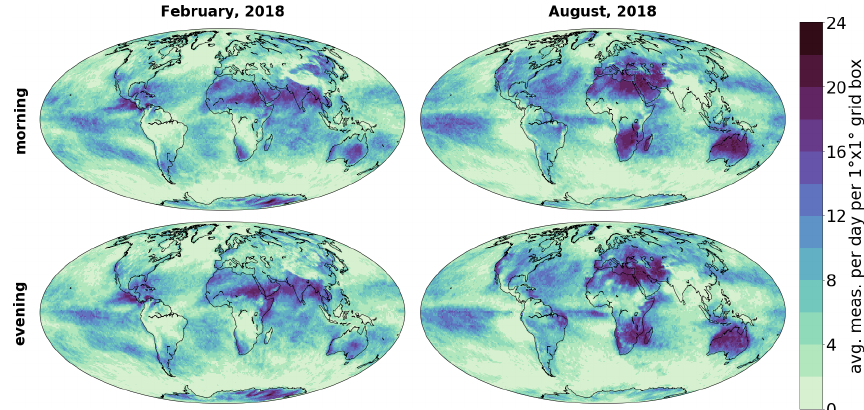
Figure 2. Monthly averaged number of the IASI observations per 1 ◦ × 1 ◦ box that passed our selection criteria prior to the MUSICA IASI processing, for February and August 2018 and for local morning and evening overpasses.